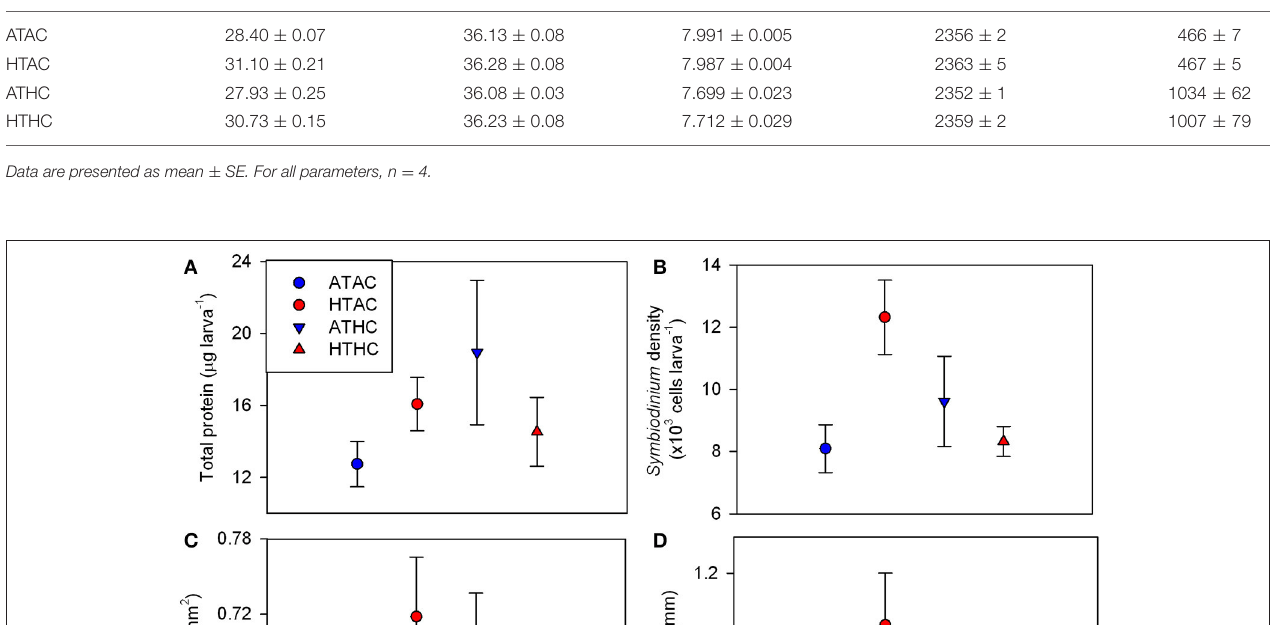
TABLE 1 | Summary of physical conditions in experimental aquaria. Treatment